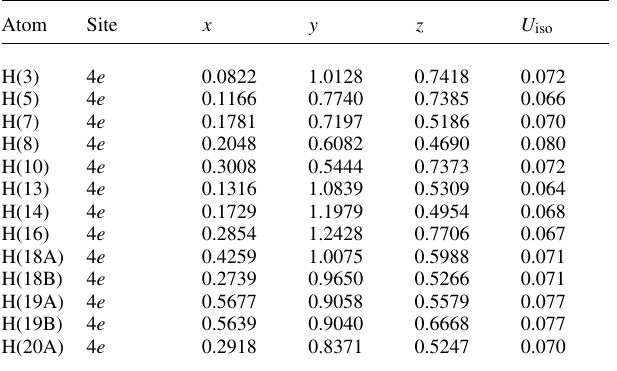
Table 2. Atomic coordinates and displacement parameters (in Å 2 )